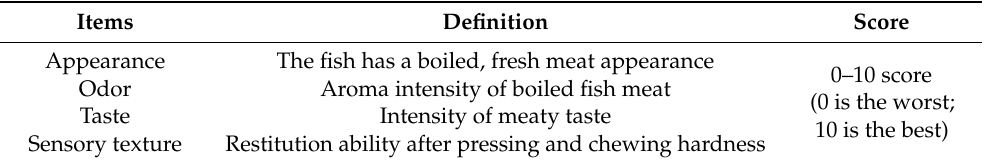
Table 1. Definition of sensory parameters used in the quantitative descriptive analysis of the crucian carp